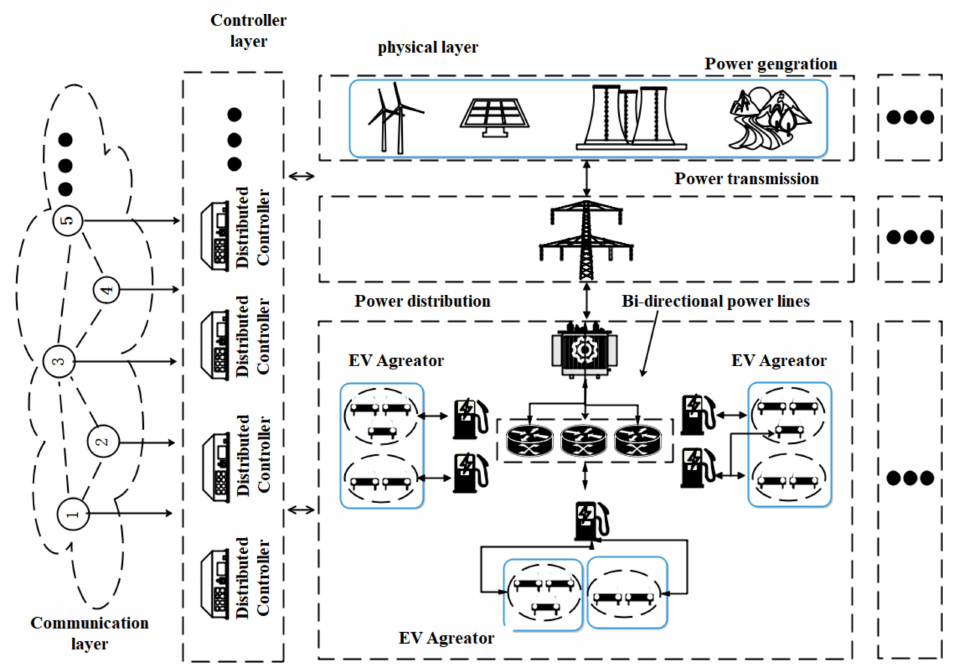
Figure 1. Smart grid architecture with consensus-based applications of electric vehicle